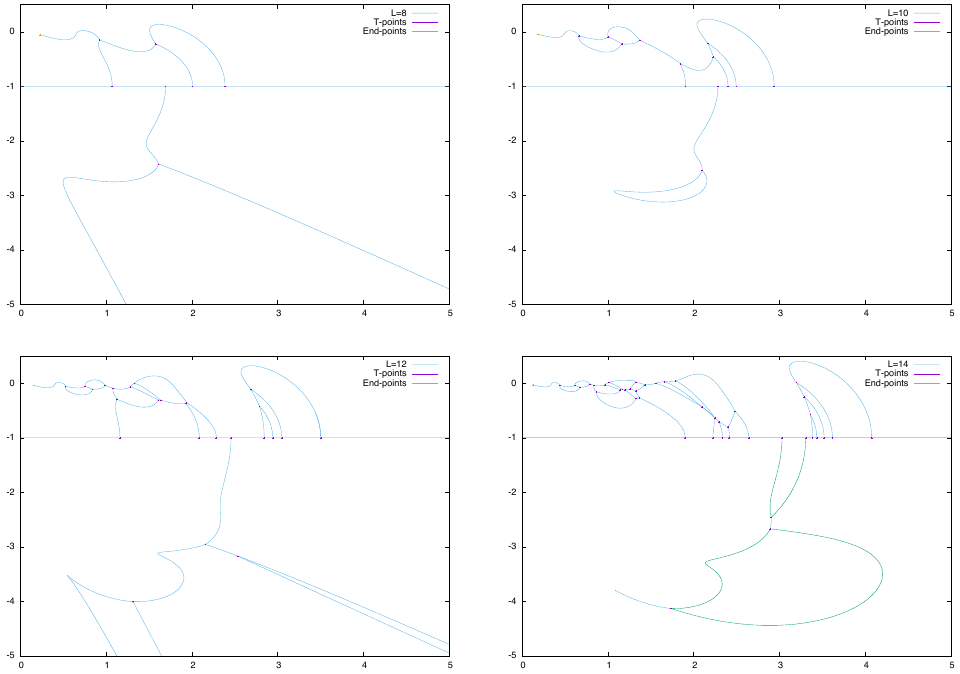
Figure 9 . Condensation curves for partition function zeros on a (2 M + 1) (cid:2) 2 N cylinder, in the limit M ! 1 (closed channel), for a system exhibiting spin-zero and cyclic symmetry Z N . The panels show, in reading direction, the cases N = 4 ; 5 ; 6 ; 7.